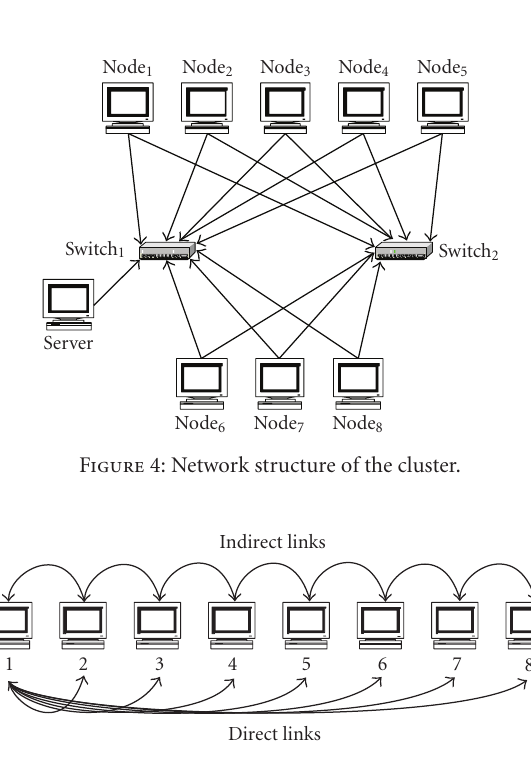
Figure 5: Direct and indirect paths between the node 1 and other